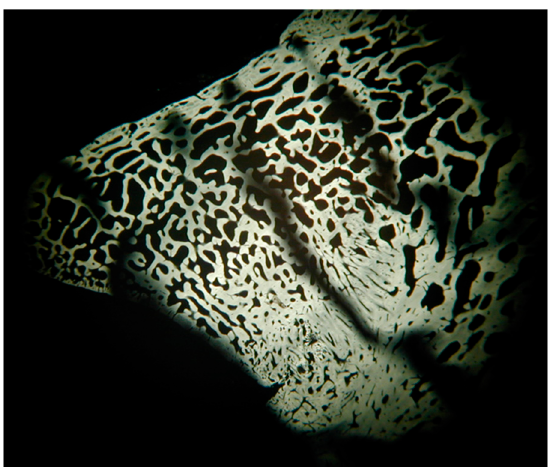
Figure 4. Microradiograph of bone tissue taken from the anconeal process.